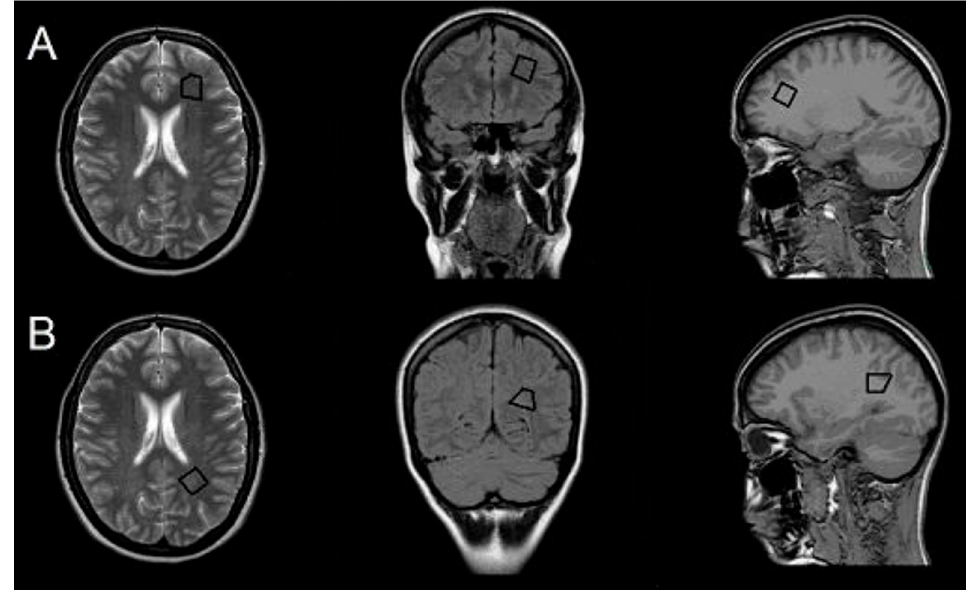
Figure 1. Volume of interest. Positions of volumes of interest (VOIs) in normal-appearing white matter (NAWM) in frontal ( A ) and parietal ( B ) regions.